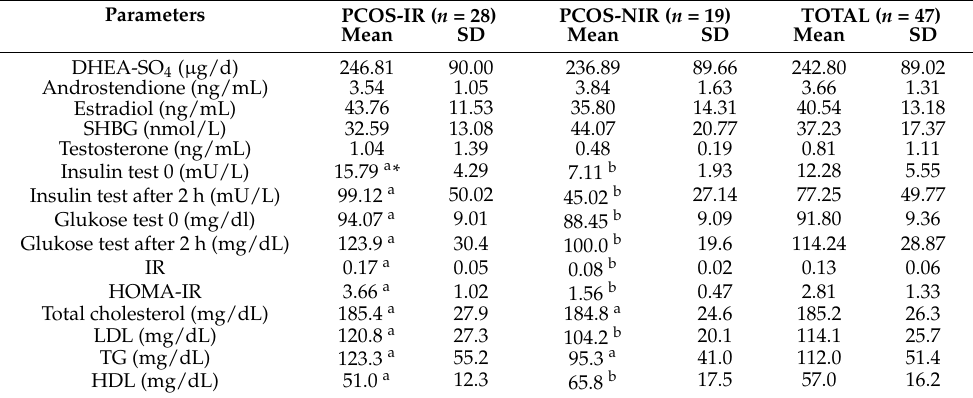
Table 2. Biochemical differences between PCOS with and without insulin